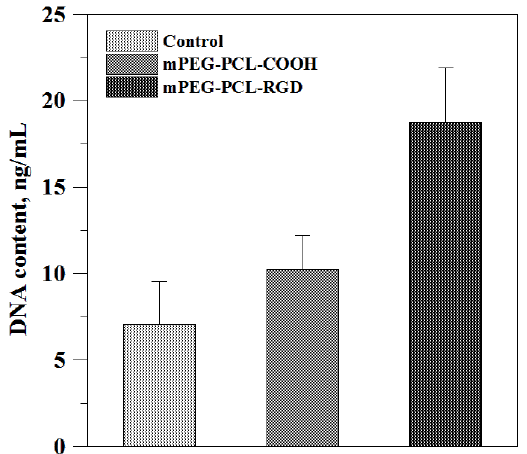
Figure 8. The DNA content of cell adhesion on 2D materials. Three days after cell culture, DNA detection showed that grafting RGD peptide in the material can effectively enhance cell attachment and proliferation.